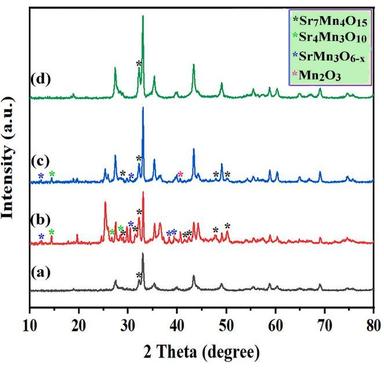
XRD patterns of: (a) S4, (b) S5, (c) S6 and (d) S7.